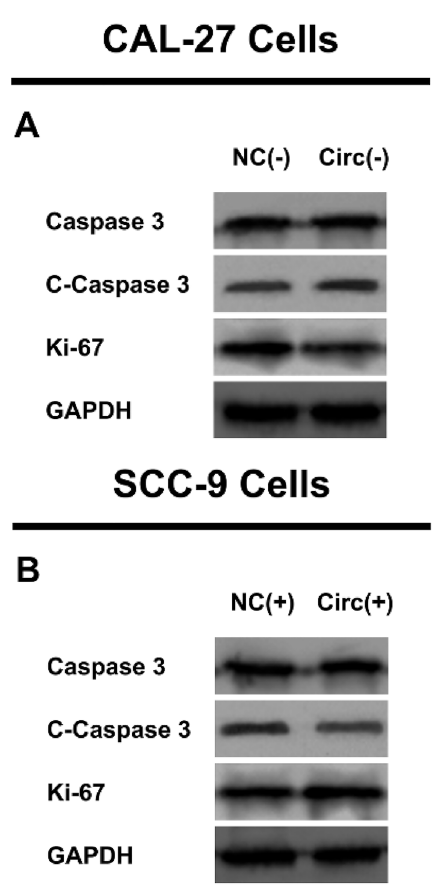
Figure 4. Regulation of hsa_circ_0002162 on proliferation/ apoptosis protein expressions in CAL-27 ( A ) and SCC-9 ( B ) cells. Hsa_circ_0002162 knock-down plasmid and circRNA control knock-down plasmid were transfected into CAL-27 cells and then divided into Circ( – ) cells and NC( – ) cells, accordingly. Hsa_circ_0002162 overexpression plasmid and circRNA